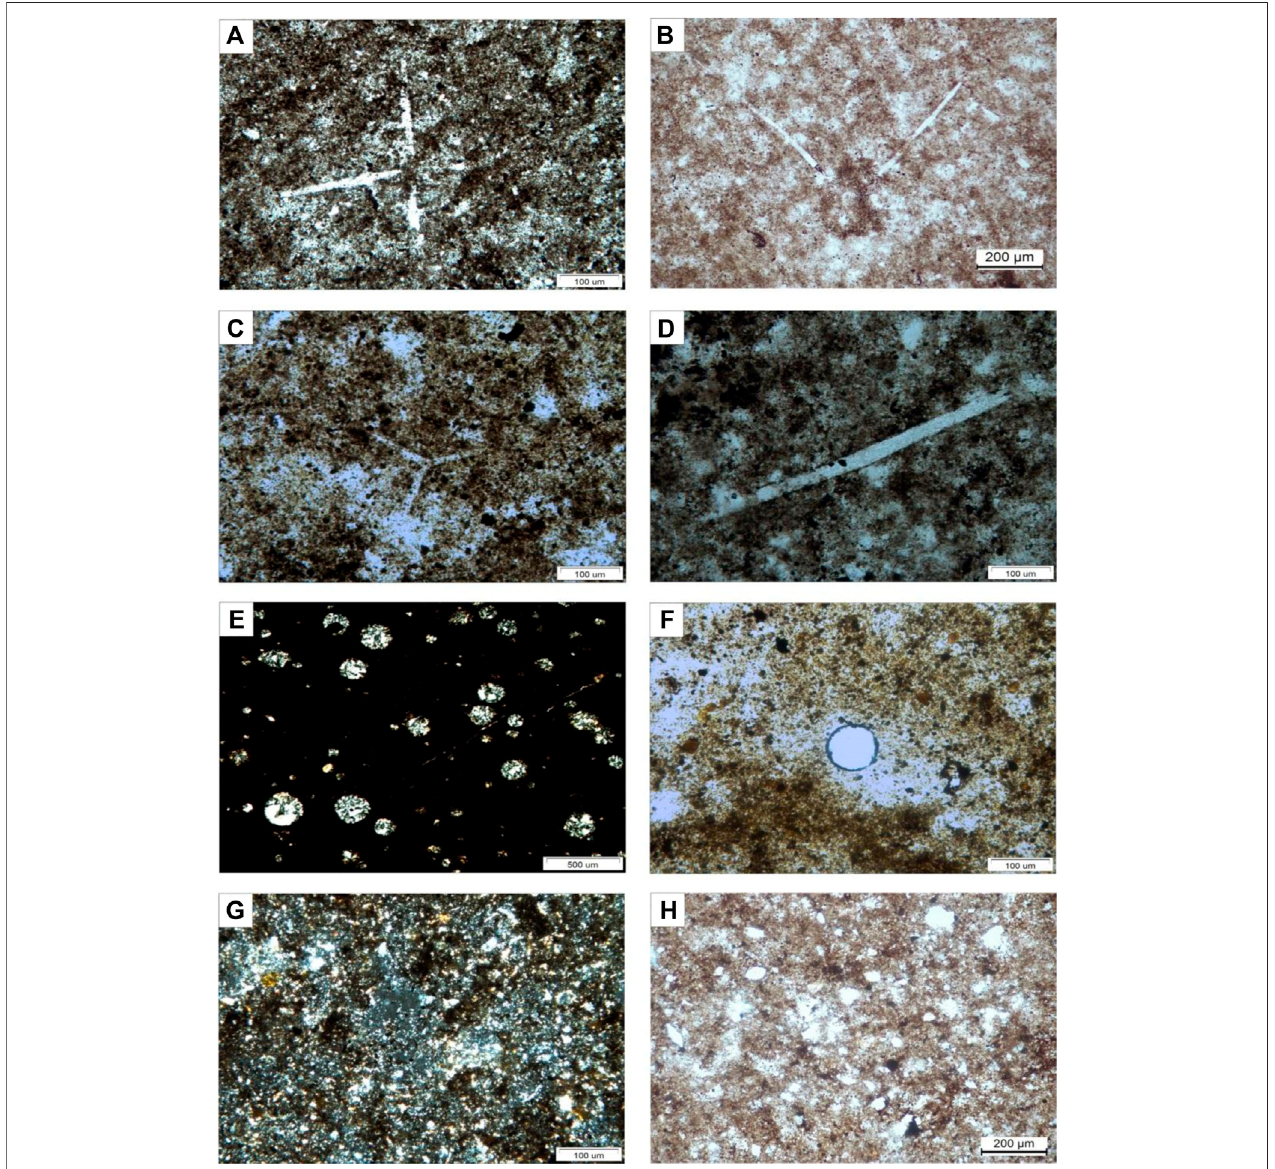
FIGURE 4 | The features of quartz under the microscope. (A) is a complete radiolarian, basically, 4,758.0 m, plane-polarized light. (B) The radiolarian has been destroyedandonlyhasitsspines,4,756.5 m,plane-polarizedlight. (C) Thespongehasthreespines,4,755.2 m,plane-polarizedlight. (D) Thisspongespecieswithone directionisthemostabundantintheWulalikeFormation,4,755.0 m,plane-polarizedlight. (E) Manyalgaeexistinone fi eldofview,mostofwhichare200 μ mindiameter, 4,748.6 m, cross-polarized light. (F) The algae are surrounded by organic matter, 4,747.5 m, plane-polarized light. (G) Fine-grained microcrystalline quartz is in dark blue, which has an amorphous form, 4,732.0 m, cross-polarized light. (H) The detrital quartz is subangular and has poor sorting property, 4,730.5 m, plane- polarized light.